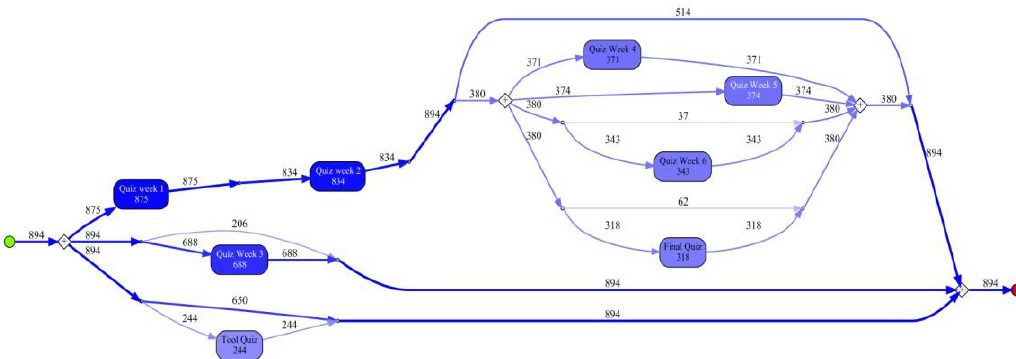
Figure 13. Quiz submission process model for cluster 3.